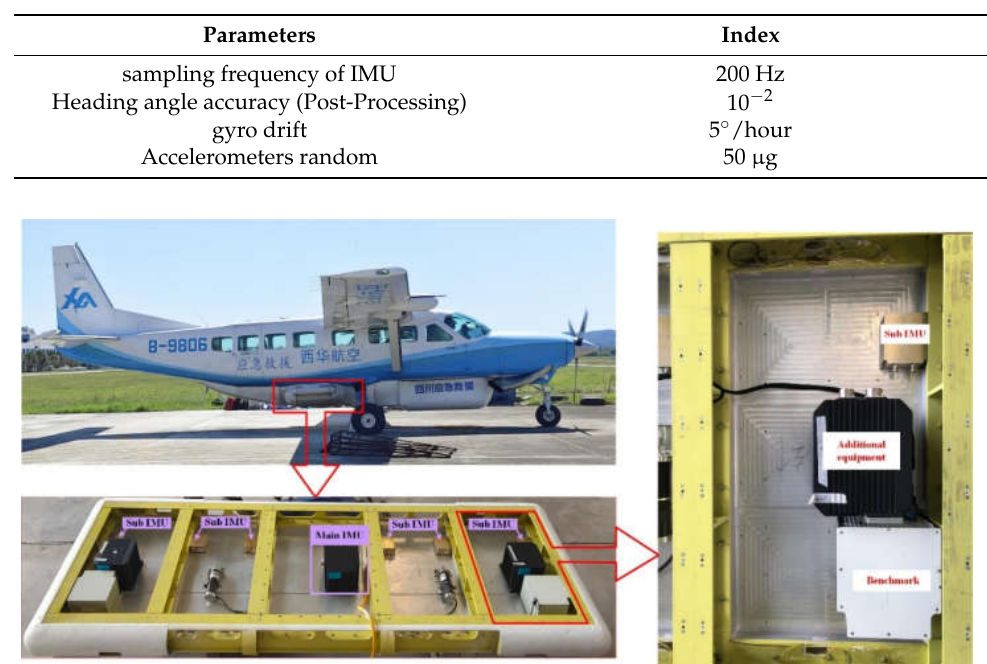
Figure 3. The flight experimental setup.